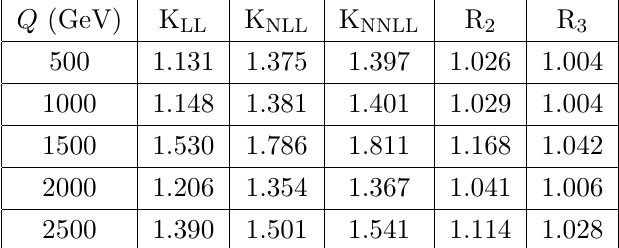
Figure 8 . Di-lepton invariant mass distribution up to NNLO+NNLL for RS model (left) and for the signal (right).